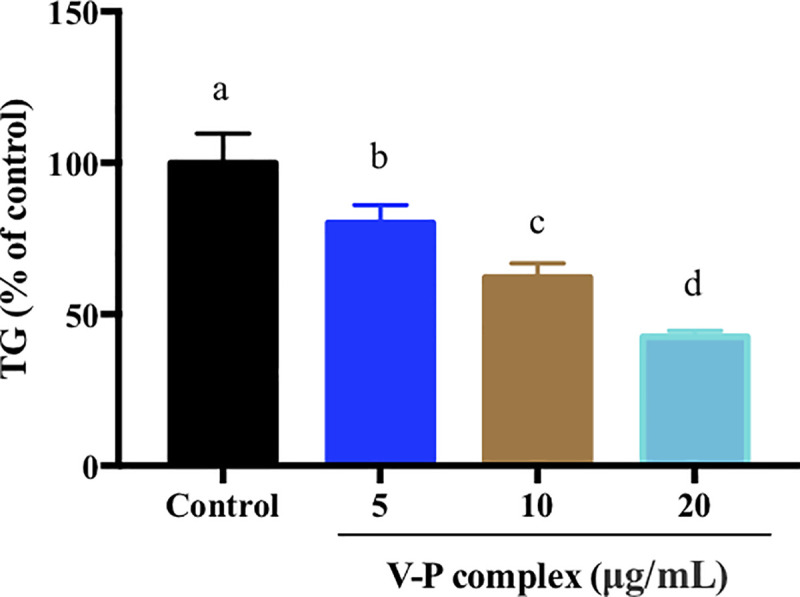
Effect of V-P complex on cellular triglyceride mass.All values present the mean ± SD (n = 5) of three independent experiments. a, b, c, d Different letters indicate a significant difference (p< 0.05) within the graph.